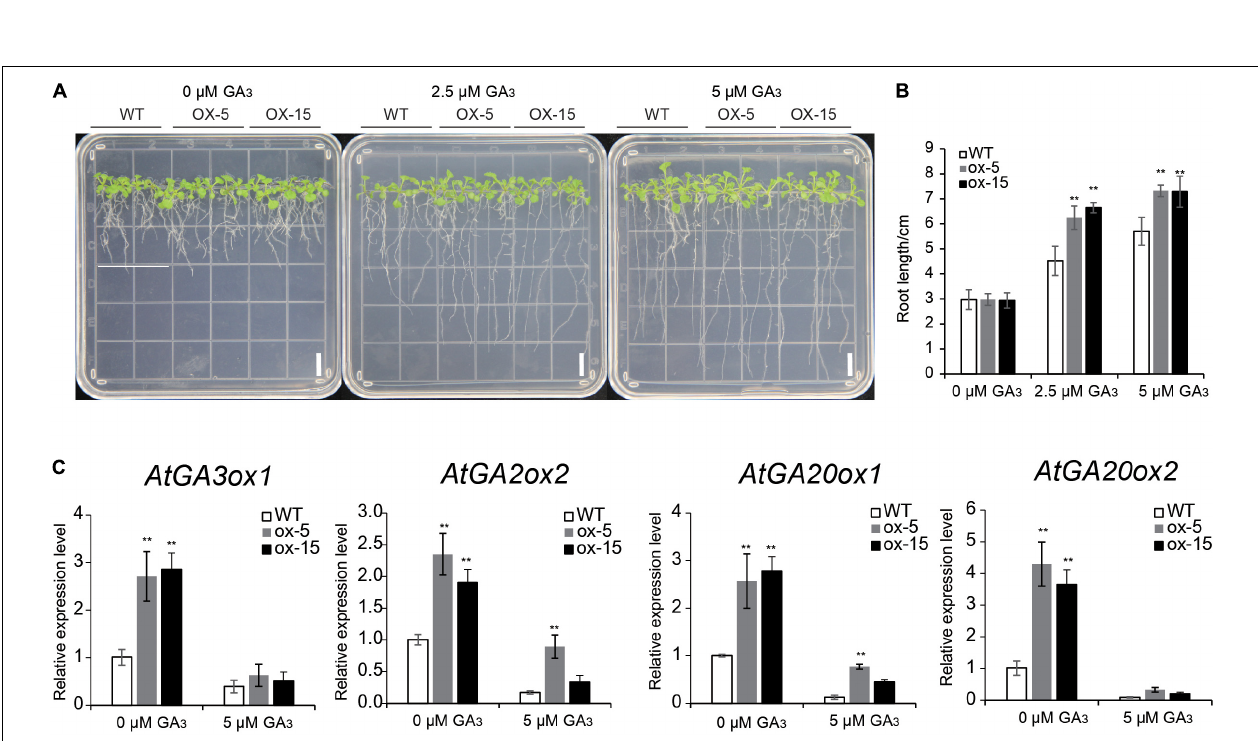
FIGURE 9 | Overexpression of BdGATA13 increased root length in Arabidopsis seedlings under GA 3 treatment. (A) 5-day-old Arabidopsis seedlings were subjected to 0, 0.25, and 0.5 µ mol GA 3 treatment for 5 day; bars = 1 cm. (B) Comparison of primary roots in WT and transgenic lines. (C) qRT-PCR results for four gibberellin-related genes under 0 and 0.5 µ mol GA 3 . Values are means ± SD ( n = 3). Asterisks represent statistically significant differences between the indicated samples. Student’s t -tests: * P ≤ 0.05, ** P ≤ 0.01.